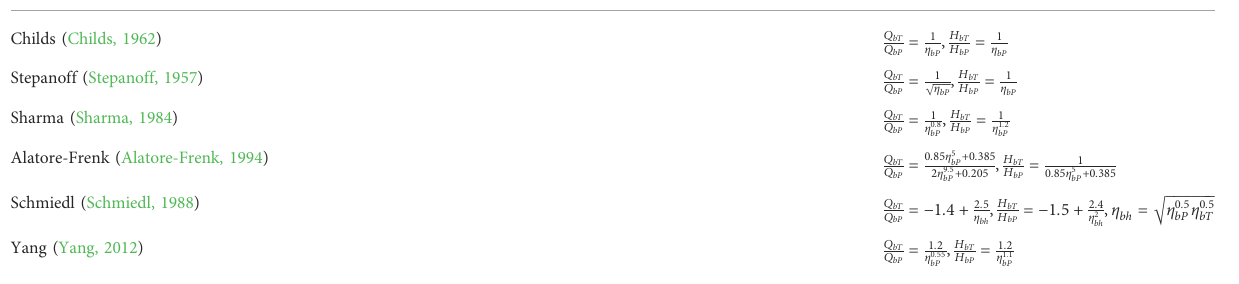
TABLE 5 BEP method performance prediction formulas.